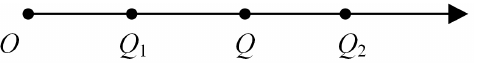
Figure 8. 1-D extension set.